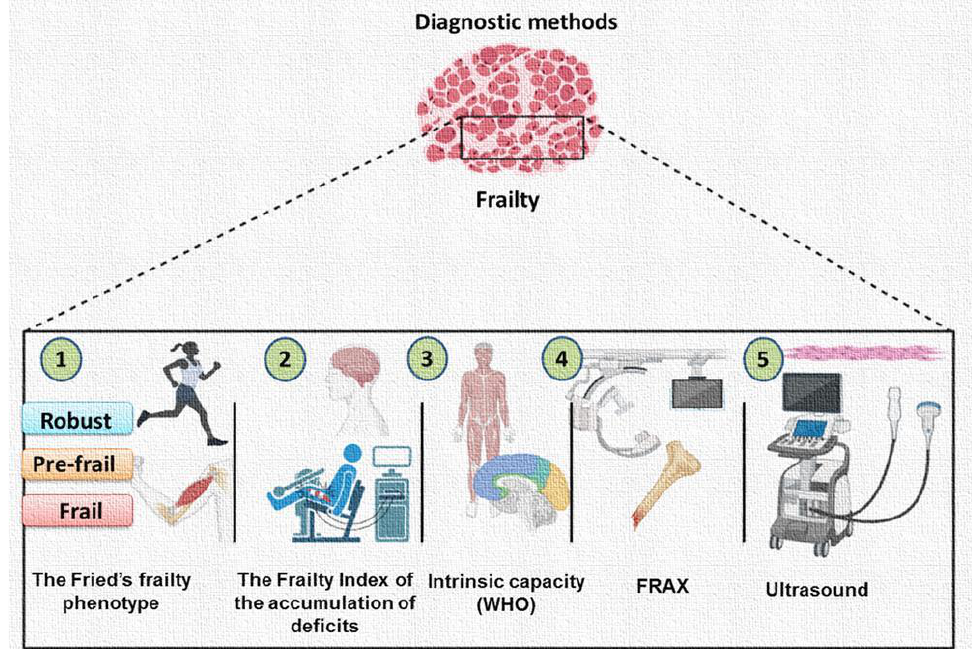
Figure 2. Diagnostic methods. (1) The Fried´s frailty phenotype focuses on physical frailty, and takes into account physical performance and muscle strength. (2) The frailty index considers different dimensions of frailty: physical capacity, cognition, and quality of life. (3) The intrinsic capacity (IC) is a multidimensional indicator of health, including determinations of mental and physical capacities. (4) The FRAX is used to measure the risk of fractures. (5) Ultrasound is a supportive tool for determining sarcopenia and frailty. Abbreviation: WHO = World Health